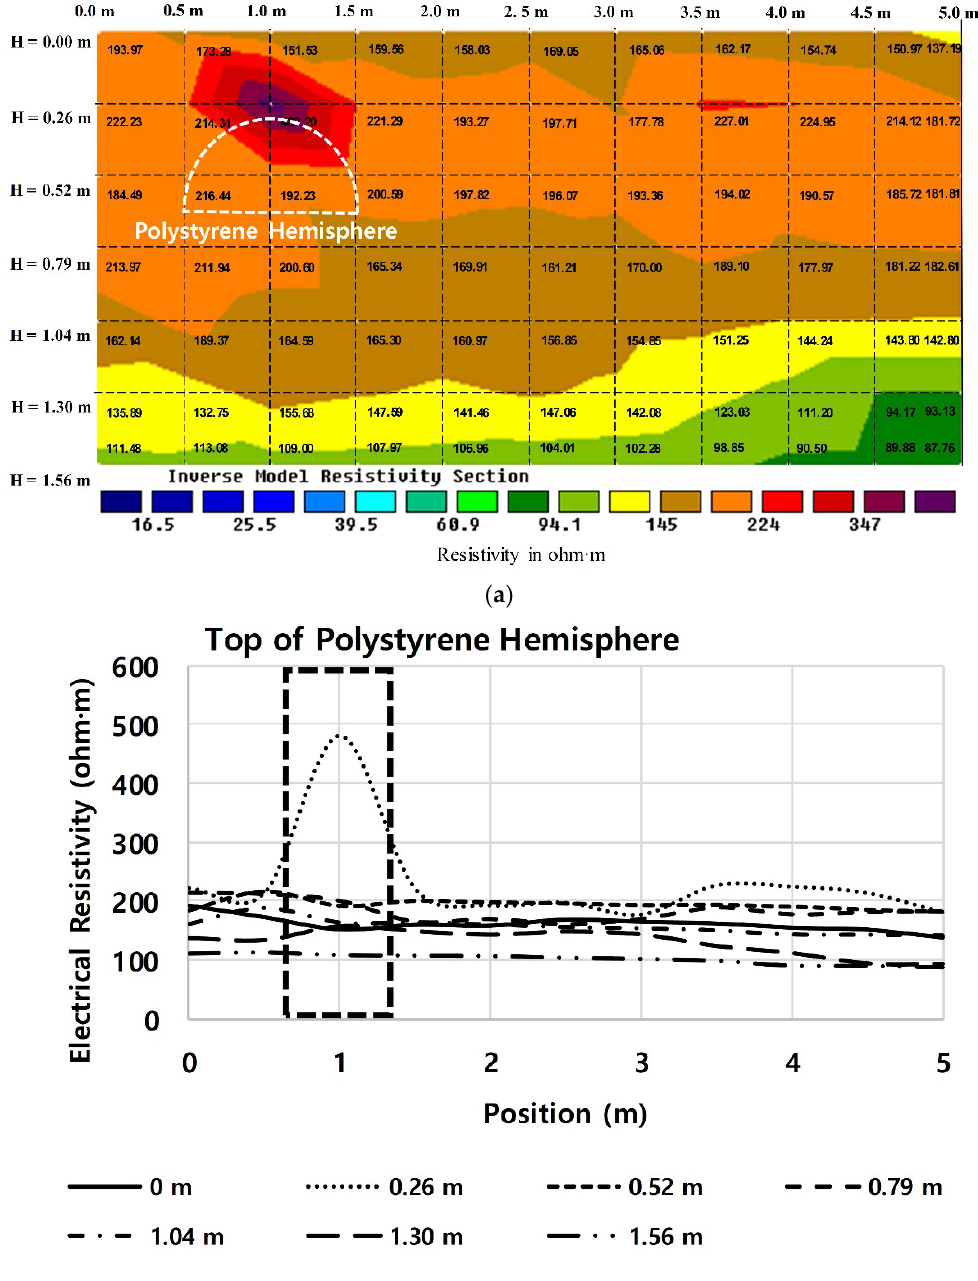
Figure 7. Test result for cavity (Section No. 4). ( a ) Distribution of the ER. ( b ) ER according to the position at each depth.